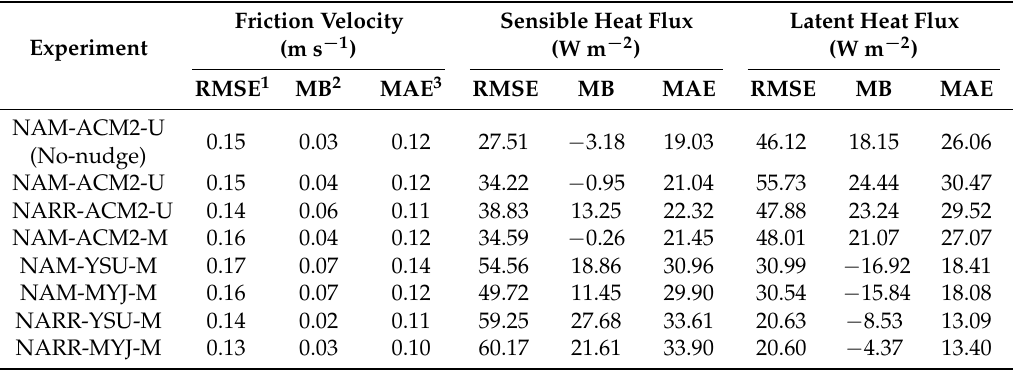
Table 3. Statistics of predicted surface turbulent variables for all schemes compared with observations. Predicted values are from the domain with the finest grid resolution (0.5